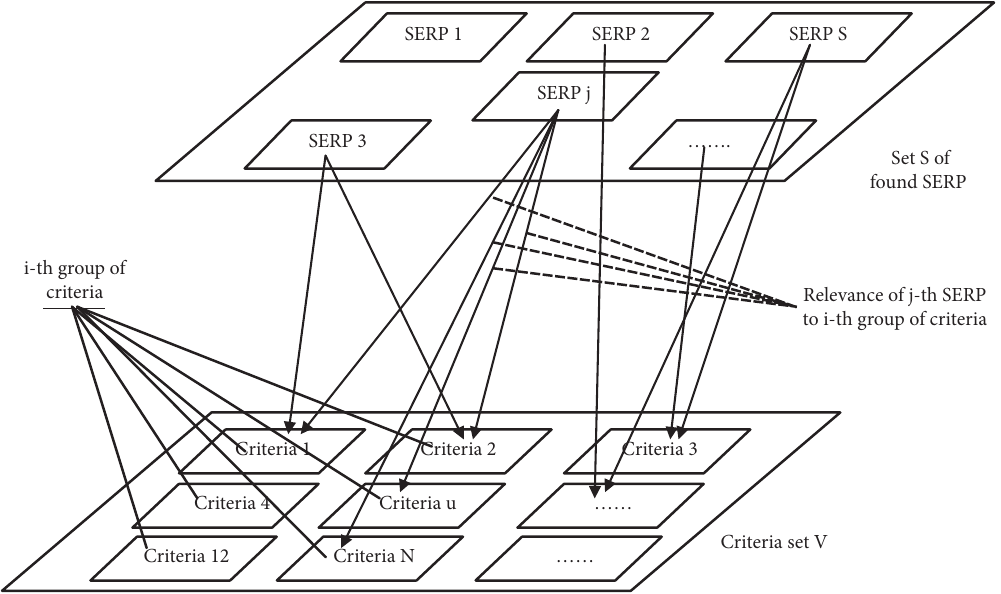
Figure 1: A group of search algorithm criteria in DIRS. Table 1: Input parameters of the assignment problem in